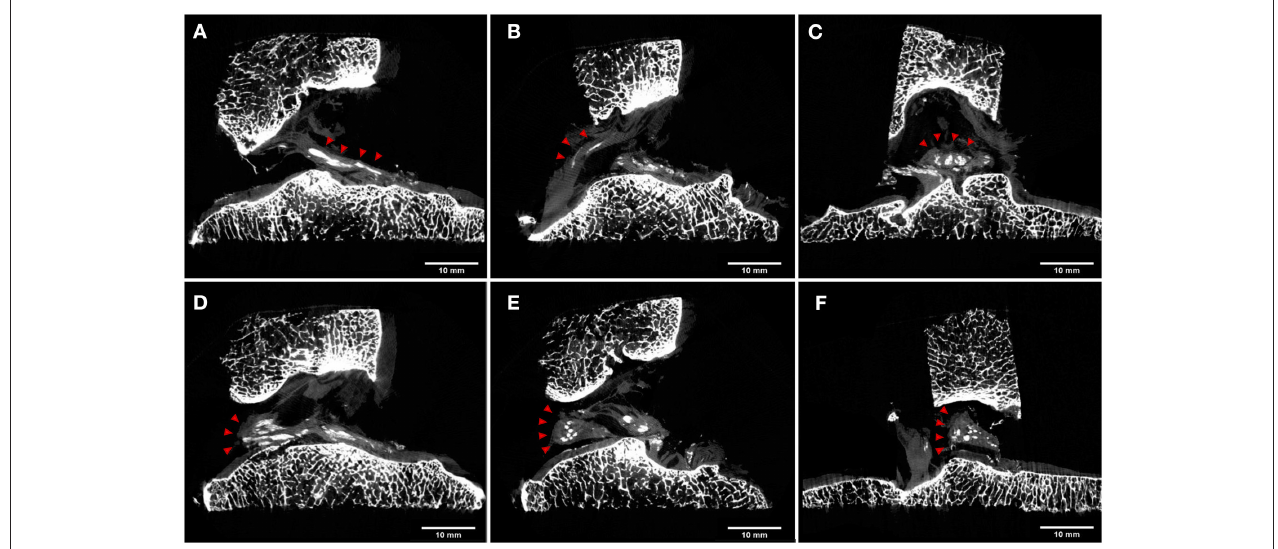
FIGURE 4 | µ CT cross sections. Calcifications are highlighted with red arrowheads. Sagittal views of ACL (A) and PCL (B) showed a linear pattern of the cruciate ligament calcifications. On the coronal plane, calcifications of ACL were characterized by an oval shape due to the virtual cut along their shortened diameter (C) . Sagittal views of lateral meniscus posterior horn insertion and flat menisco-tibial ligament (D) showed linear pattern calcifications, while the triangular meniscal remnant showed round or oval calcification both in the sagittal (E) and in the coronal (F)